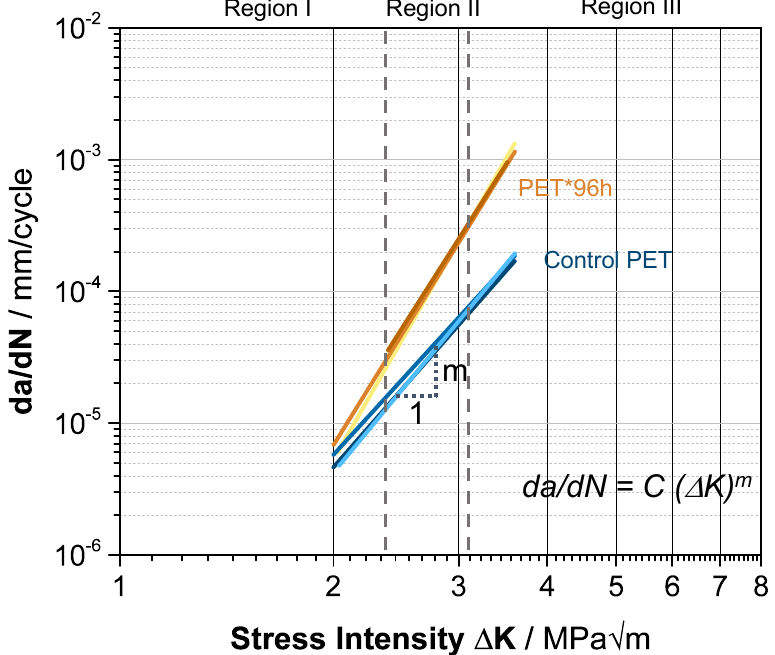
Figure 8. Power function fit of the FCP data on the linear range in region II in a double logarithmic scale with curves for the PET control (light blue, blue, dark blue) and PET*96 h (yellow, orange, dark orange). The averaged parameters for the fit are m b = 5.5 ± 1.1, C b = 10–7.9 ± 0.5 for the PET control samples, and m e = 10.2 ± 1.4, C e = 10–8.4 ± 0.6 for PET*96 h.